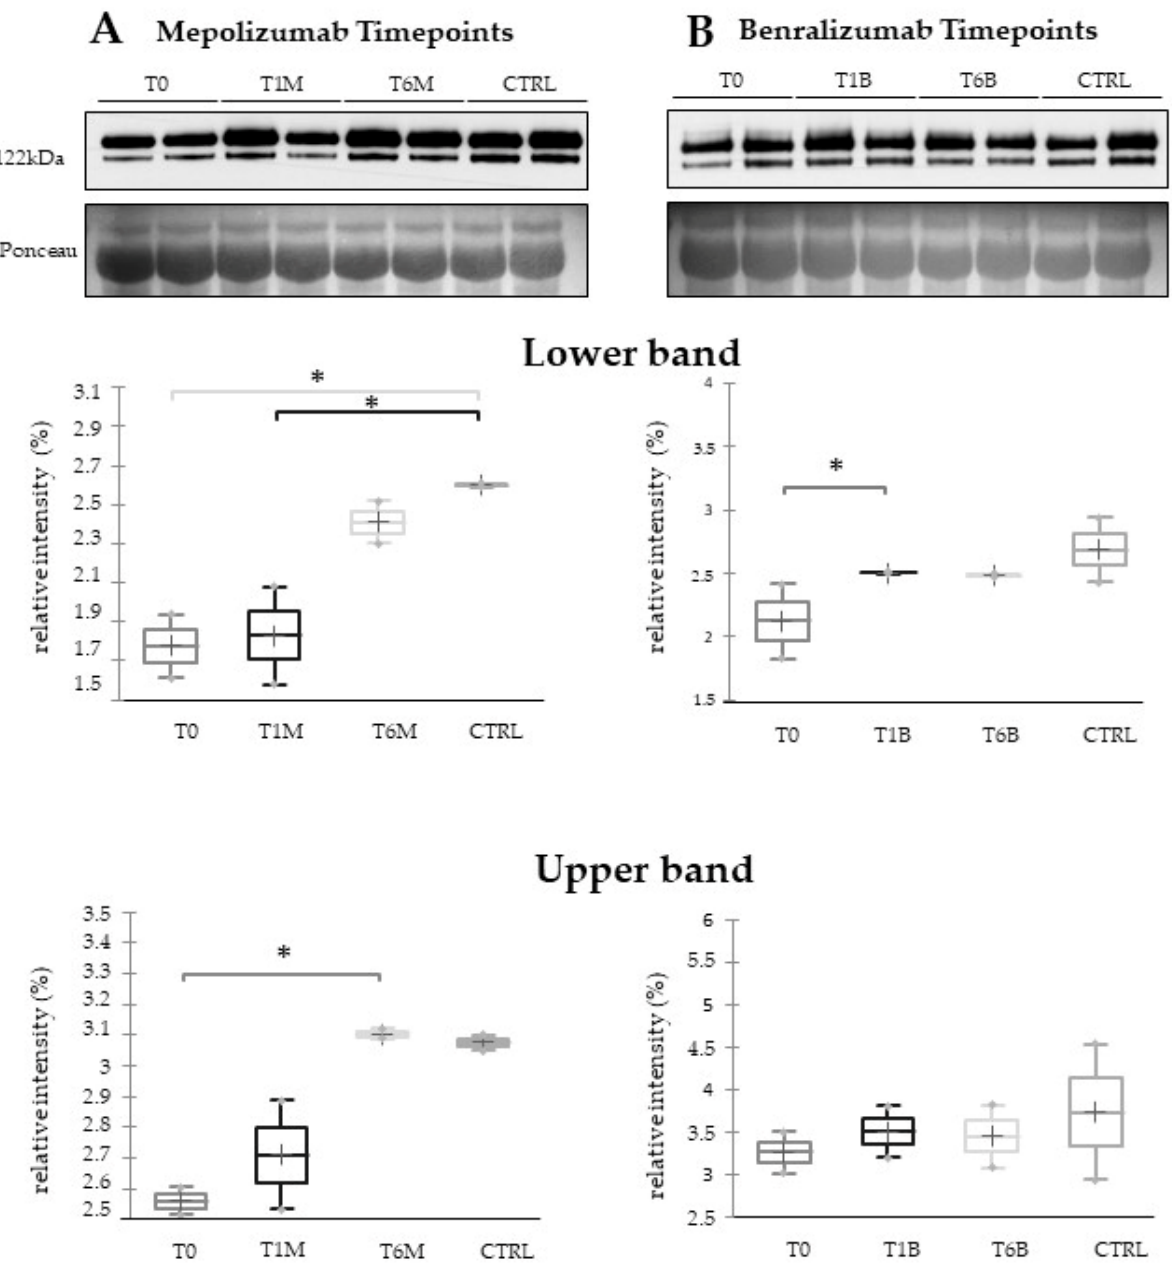
Figure 7. The 1D-Western blot analysis with anti-ceruloplasmin monoclonal antibody on serum samples from SEA patients at T0, T1M, and T6M ( A ) or T0, T1B, and T6B ( B ) and CTRLs. Kruskal– Wallis statistical analysis validates the lower band upregulation of ceruloplasmin in T1B serum and the upper band upregulation of ceruloplasmin in T6M serum. * Indicates significant level p < 0.05.